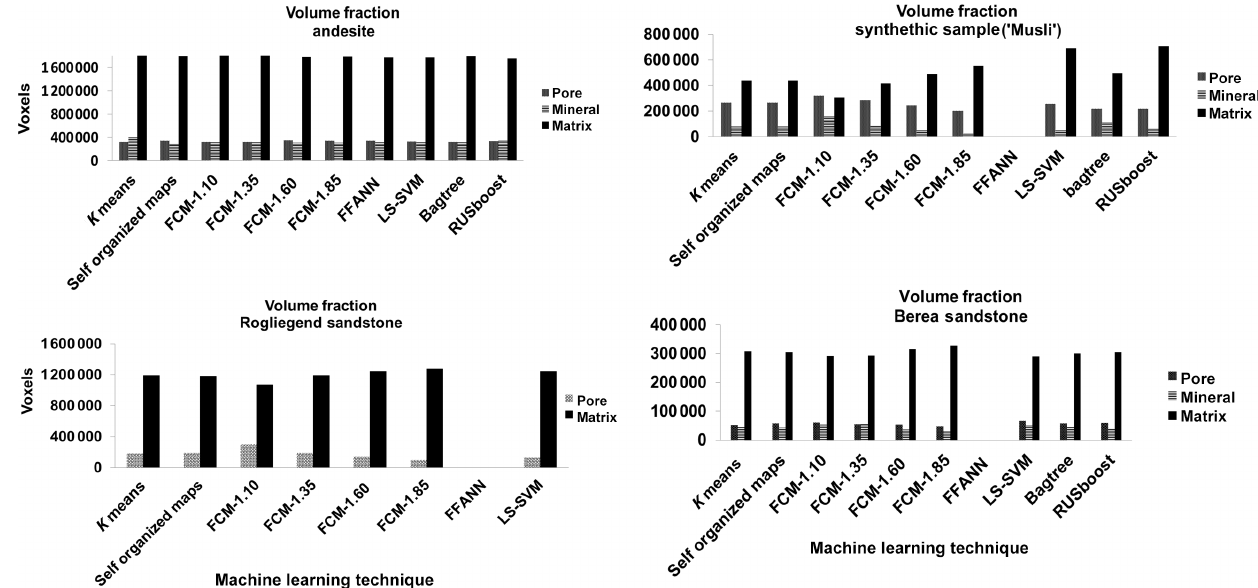
Figure 3. Total volume fraction plotted for respective